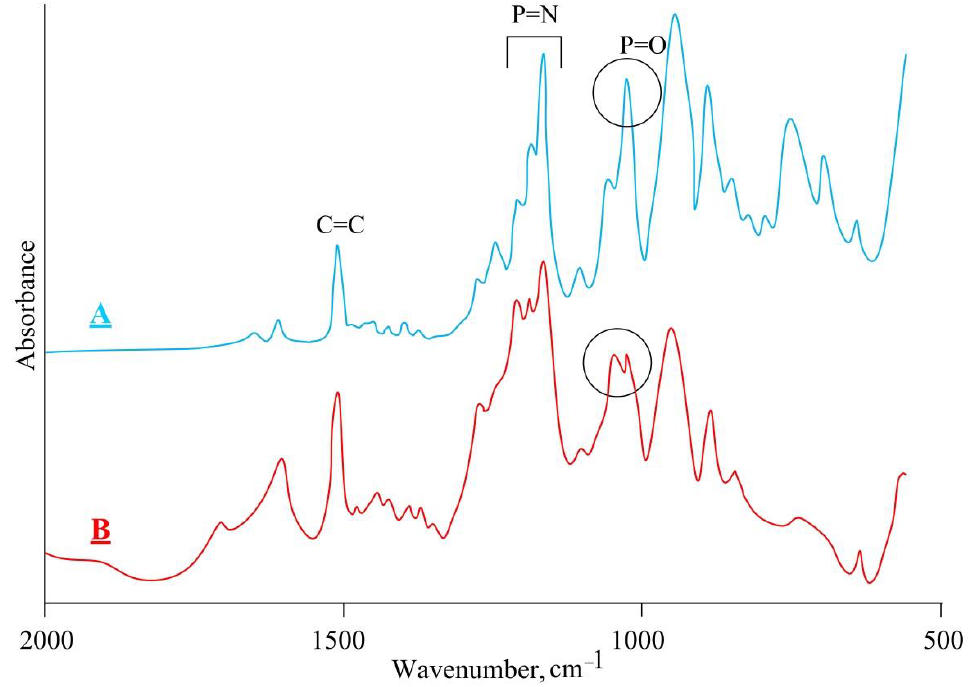
Figure 5. IR spectra of the extractant ( A ) and its palladium complex ( B ).